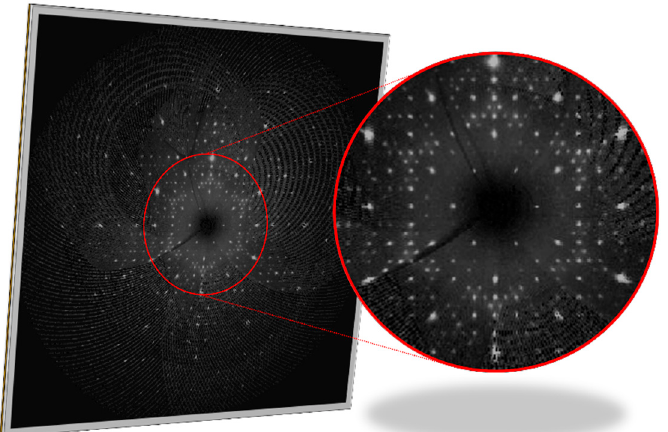
Figure 1. Hexagonal pseudo-symmetry in the X-ray diffraction pattern of spryite at 30 K due to the pervasive twinning.